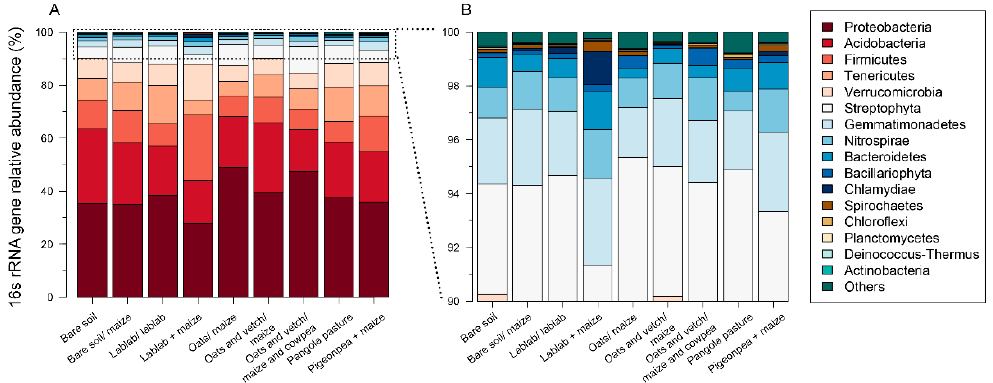
Figure 3. Phylum-level analysis of 16s RNA-based relative abundances.